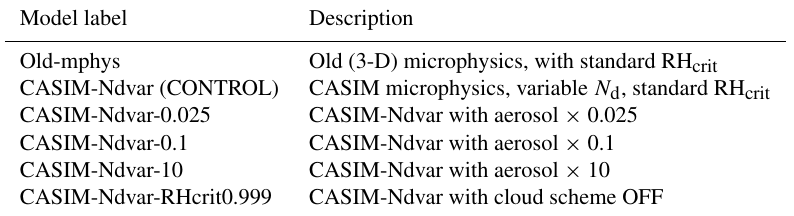
Table 4. UM model runs. “Standard RH crit ” refers to the standard profile (listed in Table A1) of the RH crit parameter that is used within the sub-grid cloud parameterization (see Appendix